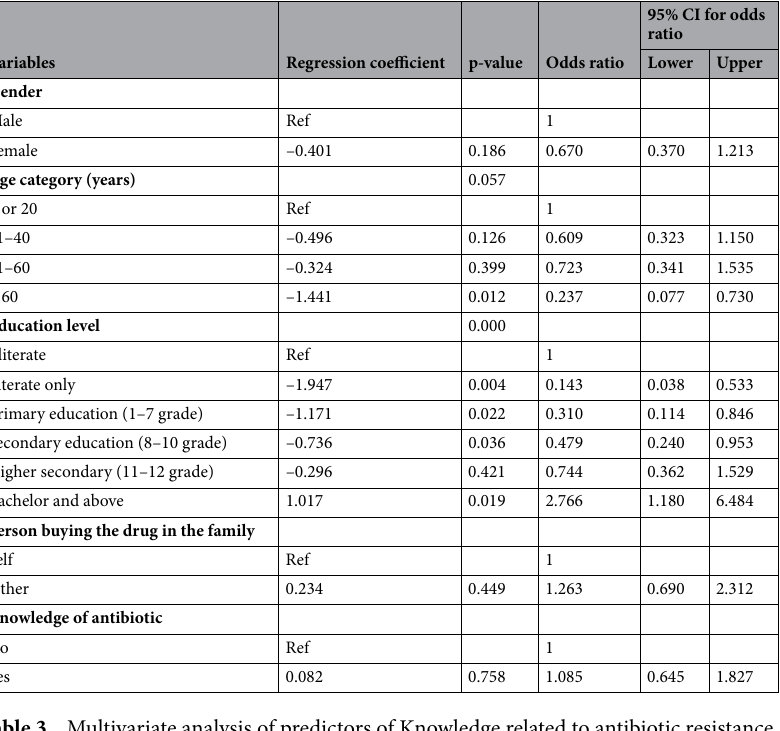
Table 3. Multivariate analysis of predictors of Knowledge related to antibiotic resistance.